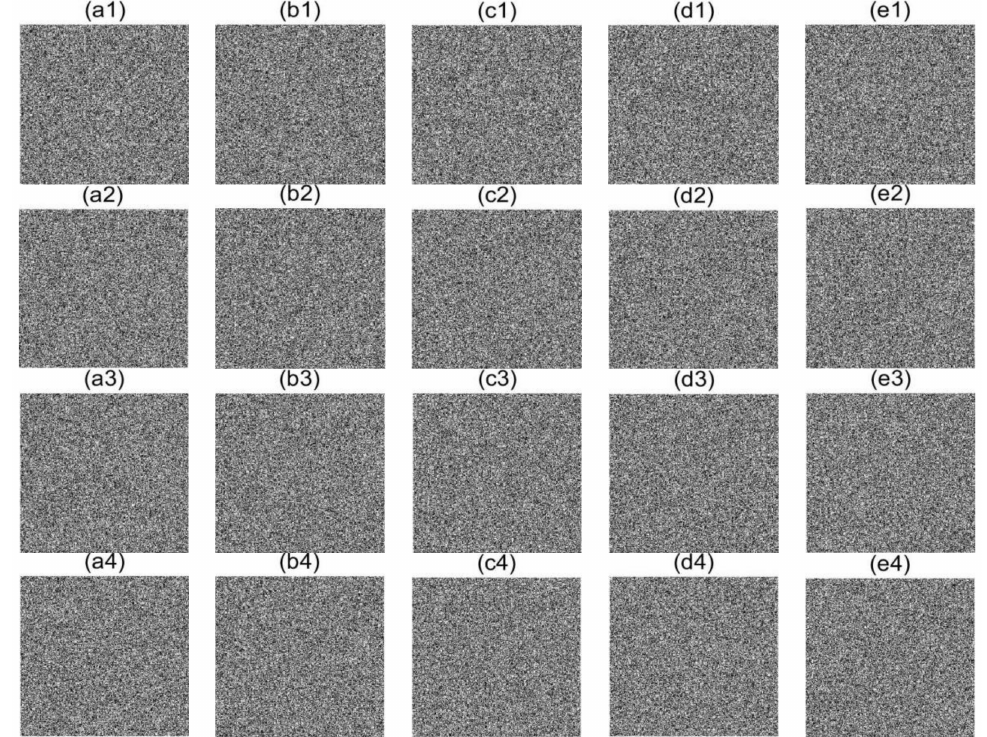
Figure 19. Decrypted images with only 10 − 10 difference in the secret keys ( a1 – e1 ): Baboon cipher images with a + 10 − 10 , x 1 + 10 − 10 , x 2 + 10 − 10 , y 1 + 10 − 10 , y 2 + 10 − 10 ; ( a2 – e2 ): Horse cipher images with